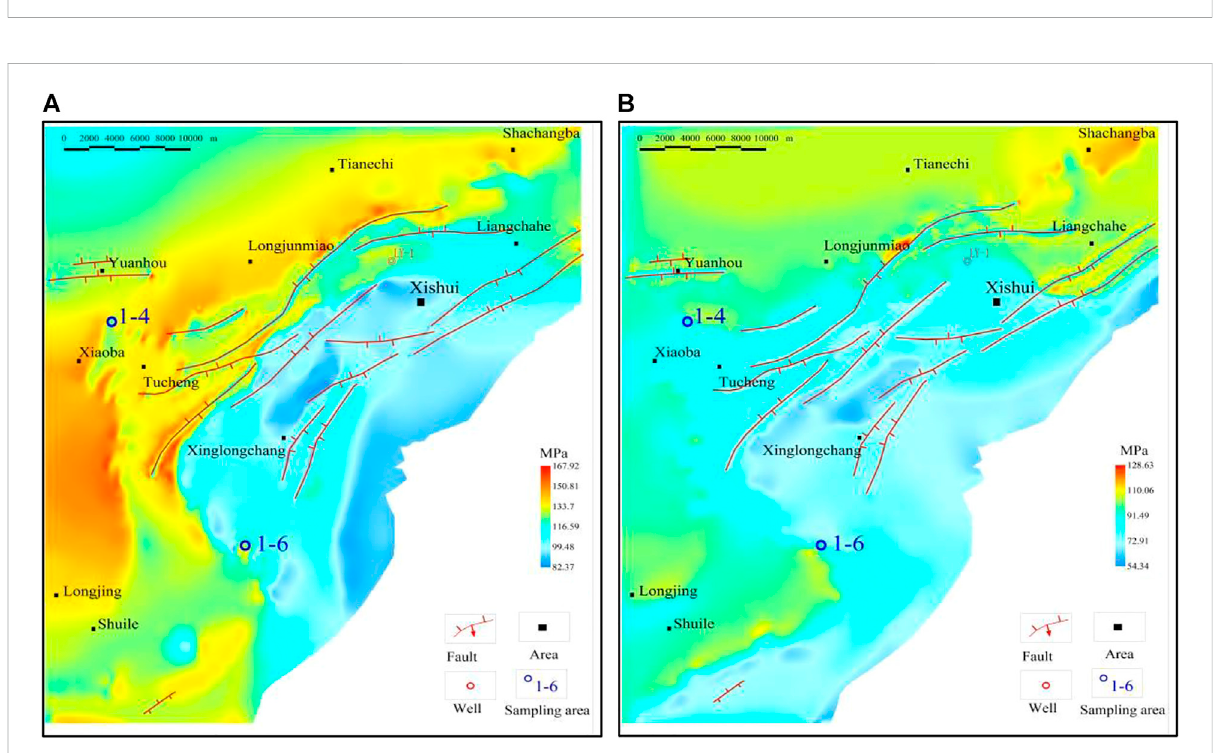
FIGURE 10 Numerical simulation results of the paleo-tectonic stress fi eld in the Lintanchang area during the late Yanshanian period ( (A) : maximum principal stress; (B) minimum principal stress).